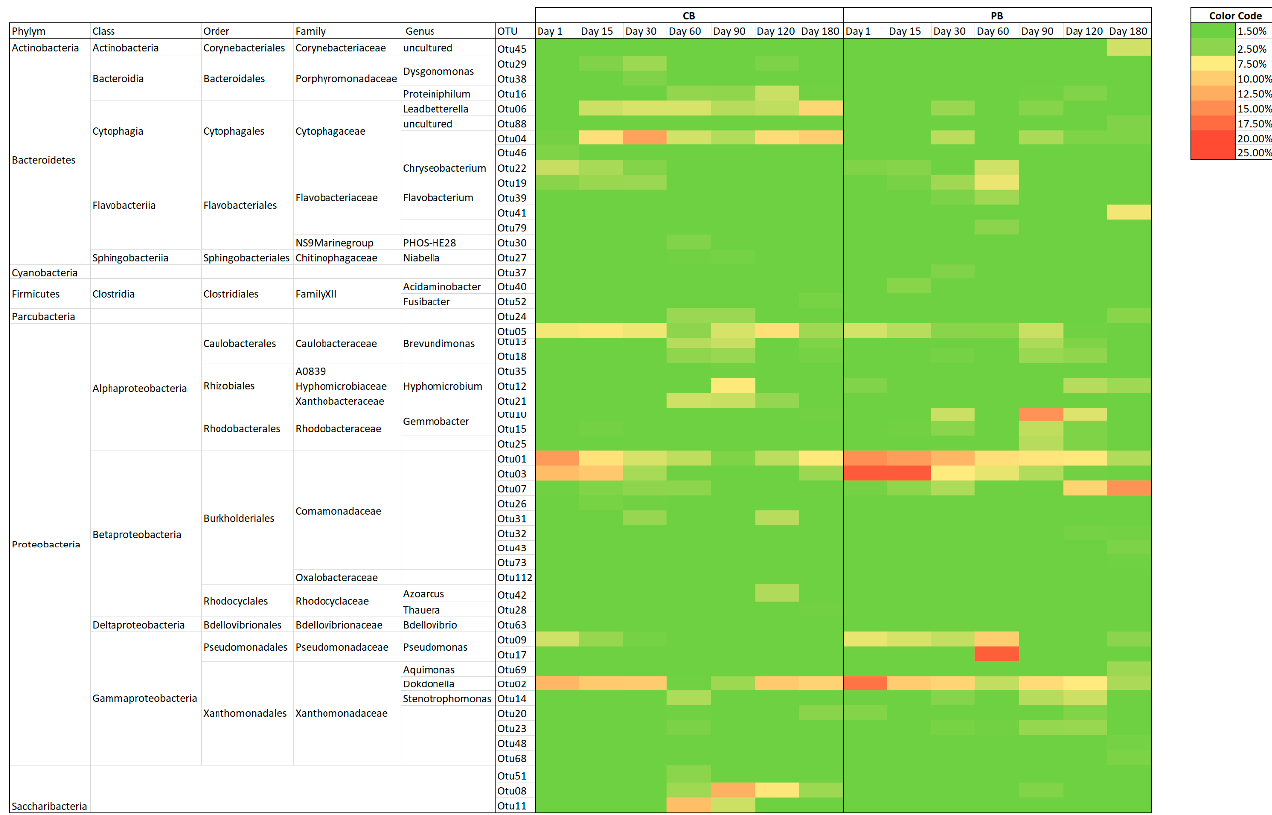
Figure 6. Distribution of the microbial community of DNA (>1.50%) in the reactors CB (control) and PB (supplemented with pharmaceuticals).